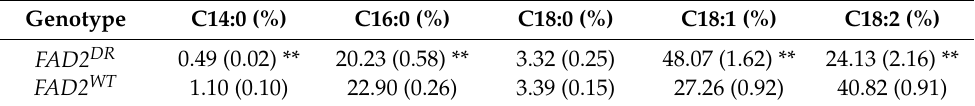
Table 1. Total fatty acid composition of brown rice flour of the selected FAD2-1 RNAi backcross lines. Genotype